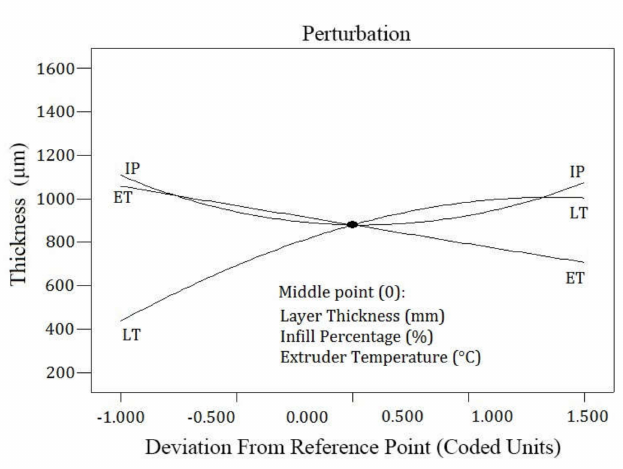
Figure 11. Perturbation plot of the maximum